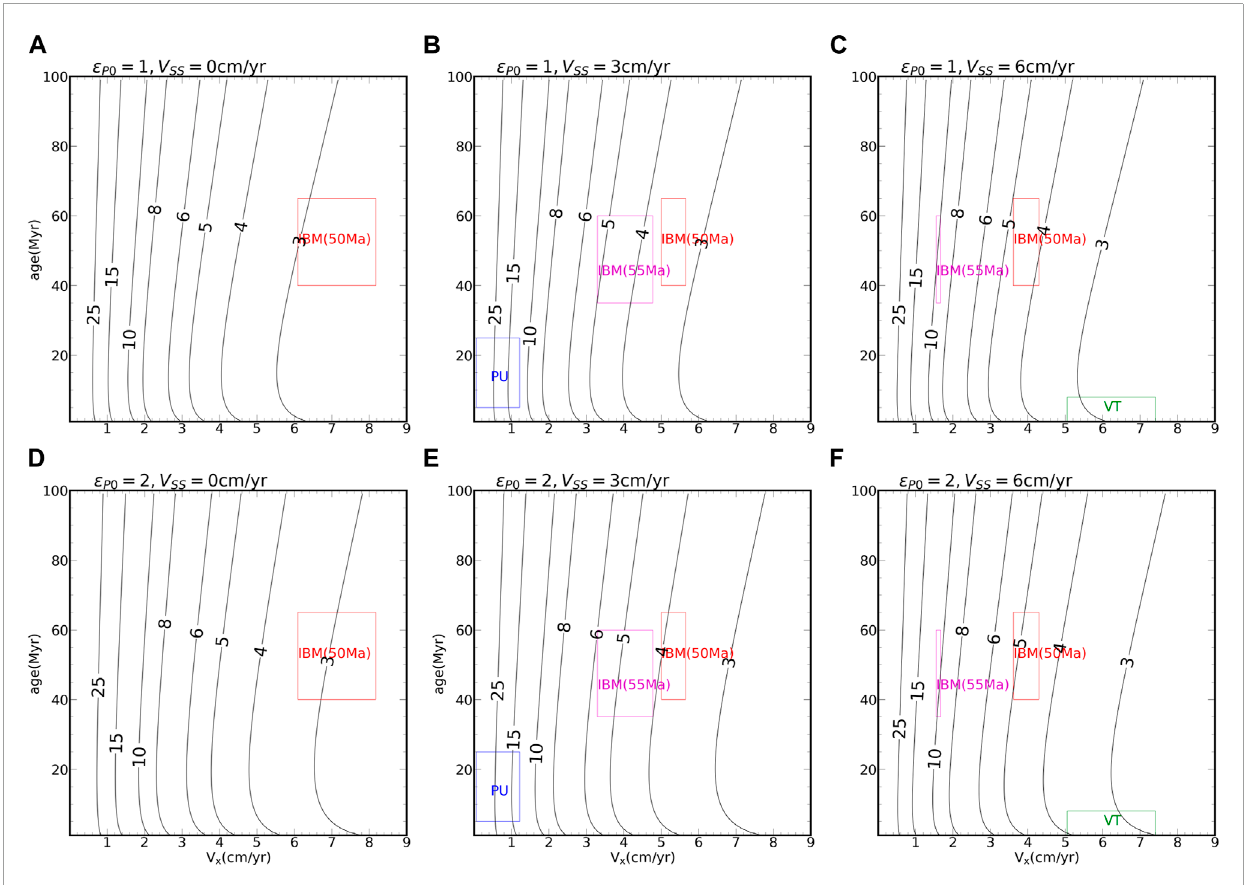
FIGURE 3 Analytical prediction of initiation time t SI under different convergent velocity Vx and subducting plate age with (A) . V SS = 0, ɛ P 0 = 1, (B) . V SS = 3 cm / yr, (C) . V SS = 6 cm / yr, ɛ P 0 = 1. (D–F) are the same as (A–C) except ɛ P 0 = 2. Red, magenta, blue and green box show the parameter range of IBM (50 Ma), IBM (55 Ma), Puysegur (PU) and Vanuatu (VT) subduction initiation from the given V SS with a ± 1 cm / yr